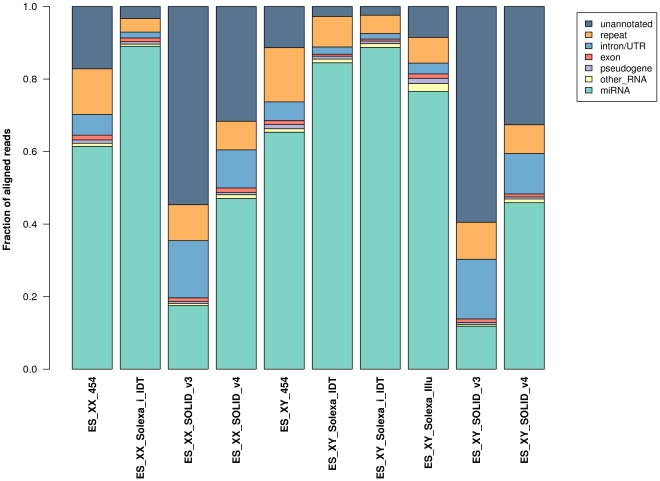
Categories of all aligned reads for the libraries investigated.The feature type of reads overlapping multiple genomic features was assigned by prioritising the feature types in the order: microRNA>other ncRNA>pseudogene>exon>gene>LINE>other repeat.